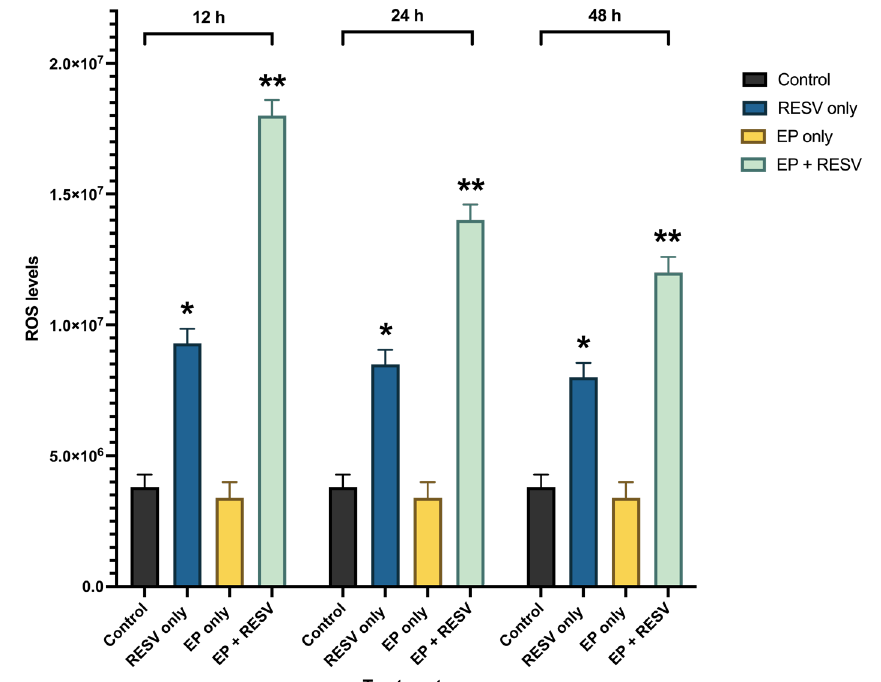
, indicates the significant * **